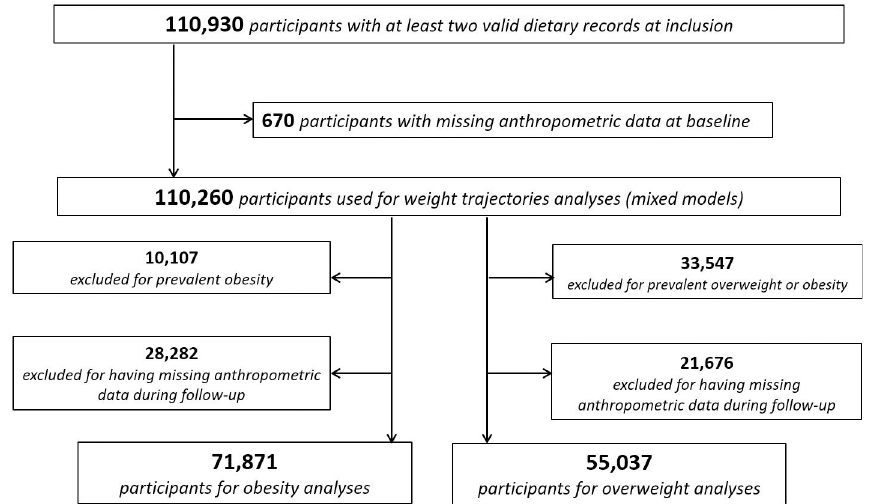
Fig 1. Flowchart for study population, NutriNet-Sante´ cohort, 2009–2019.